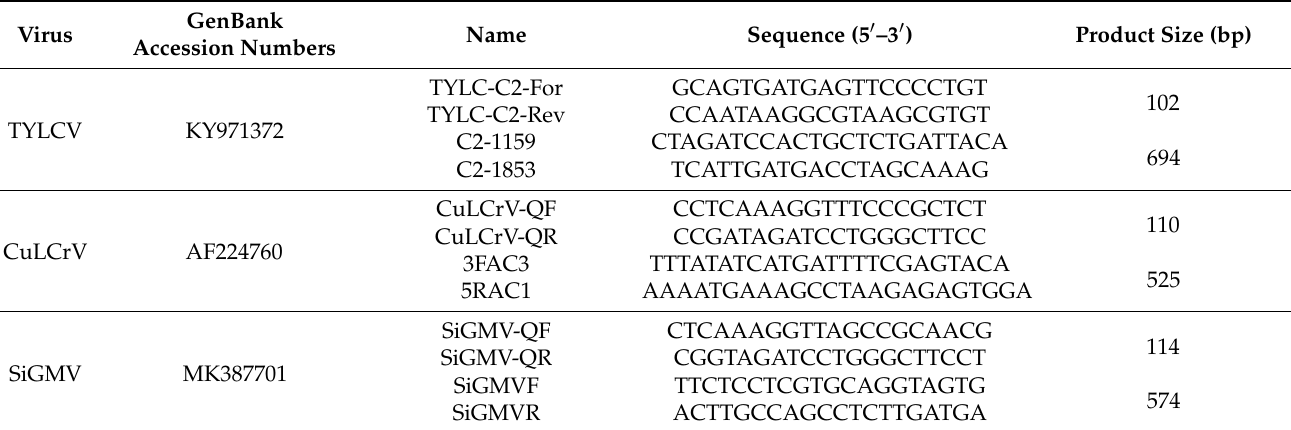
Table 1. Primers used for detection and quantitation of DNA-A of TYLCV, CuLCrV, and